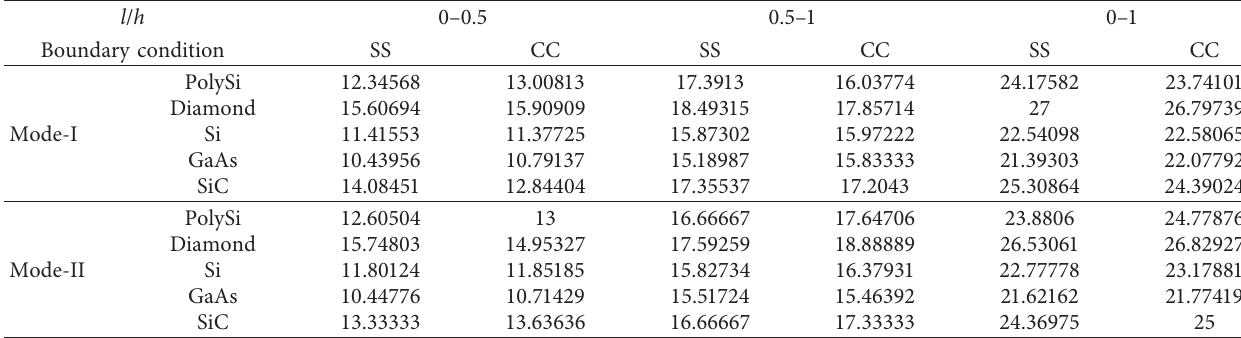
Table 4: Percentage increase (%) of critical thickness of a microplate for different structural materials with size